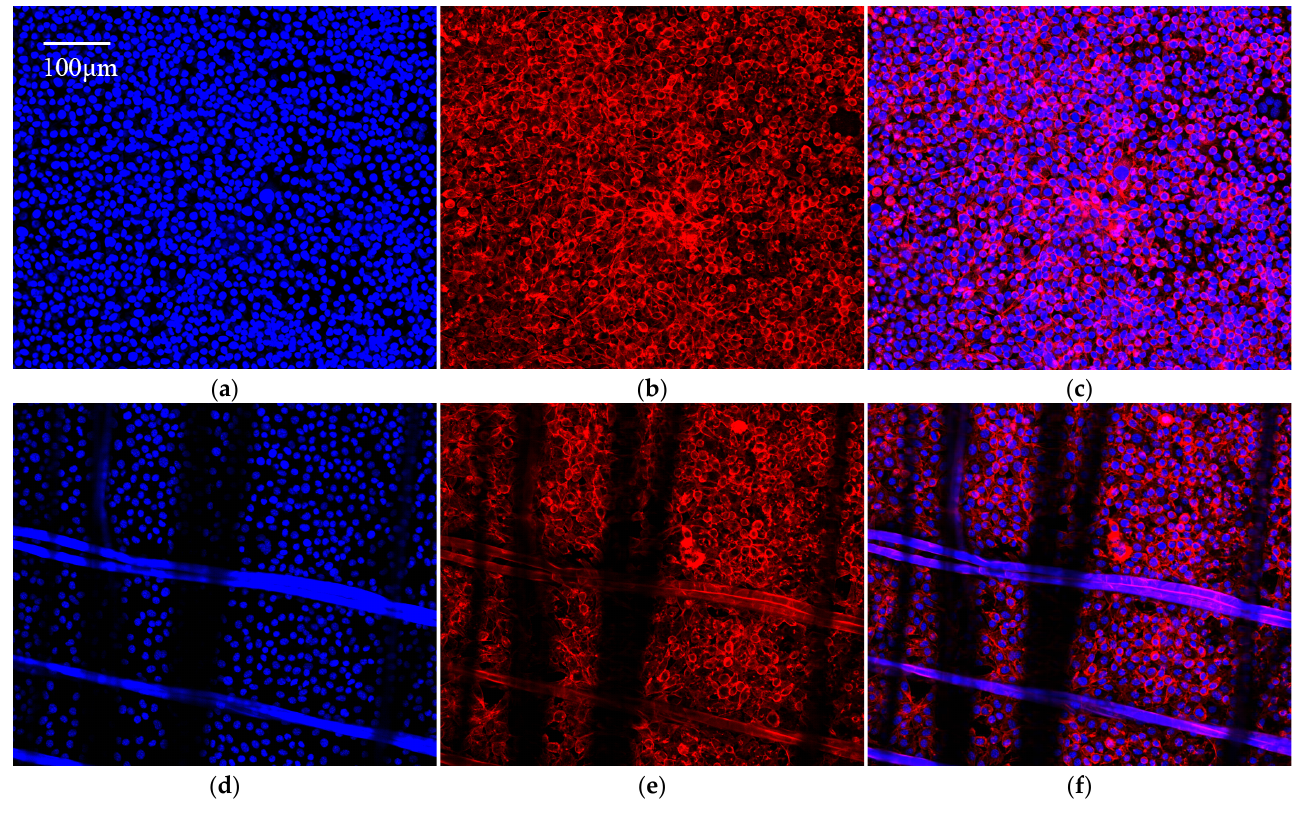
Figure 11. Growth and proliferation of L929 cells on silk scaffolds. L929 cells cultured for 24 h on coverslip ( a ), control ( b ), and CDs-0.50% silk scaffolds ( c ); L929 cells cultured for 72 h on coverslip ( a′ ), control ( b′ ) and CDs-0.50% silk scaffolds ( c′ ).